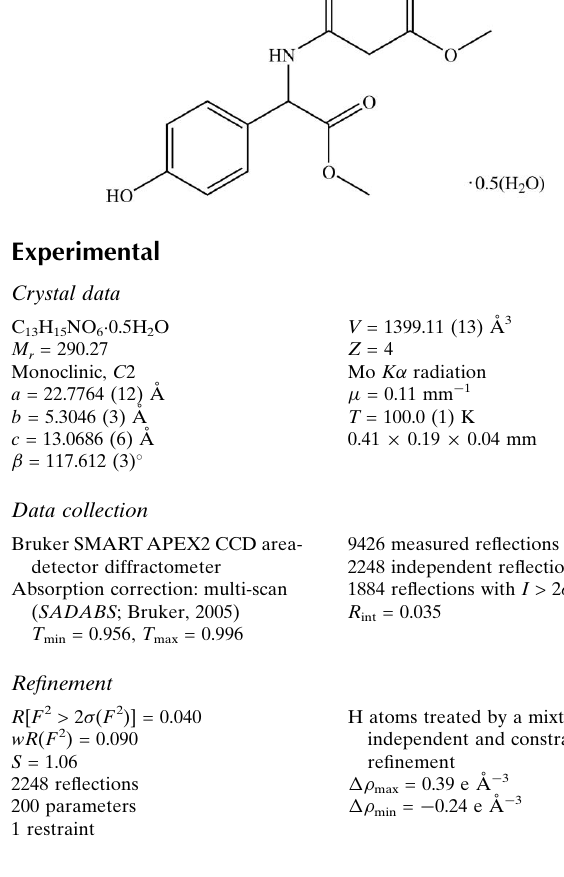
Hydrogen-bond geometry (A˚ , (cid:2) ). D —H (cid:1)(cid:1)(cid:1)